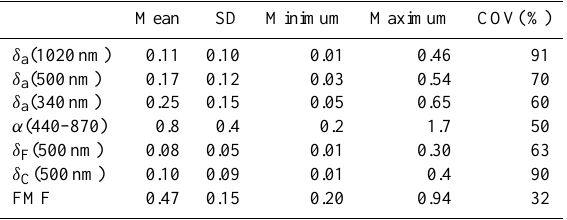
Table 1. Statistical summary of daily mean values of spectral aerosol optical depth at 1020, 500 and 340nm, Ångström expo- nent, α (440–870), fine and coarse mode aerosol optical depths at 500nm, δ F (500nm) and δ C (500nm), and fine mode fraction, FMF, observed over Alborán Island in the western Mediterranean during 1 July 2011–23 January 2012; SD is the standard deviation and COV is the coefficient of variation. Mean SD Minimum Maximum COV(%) δ a (1020nm)